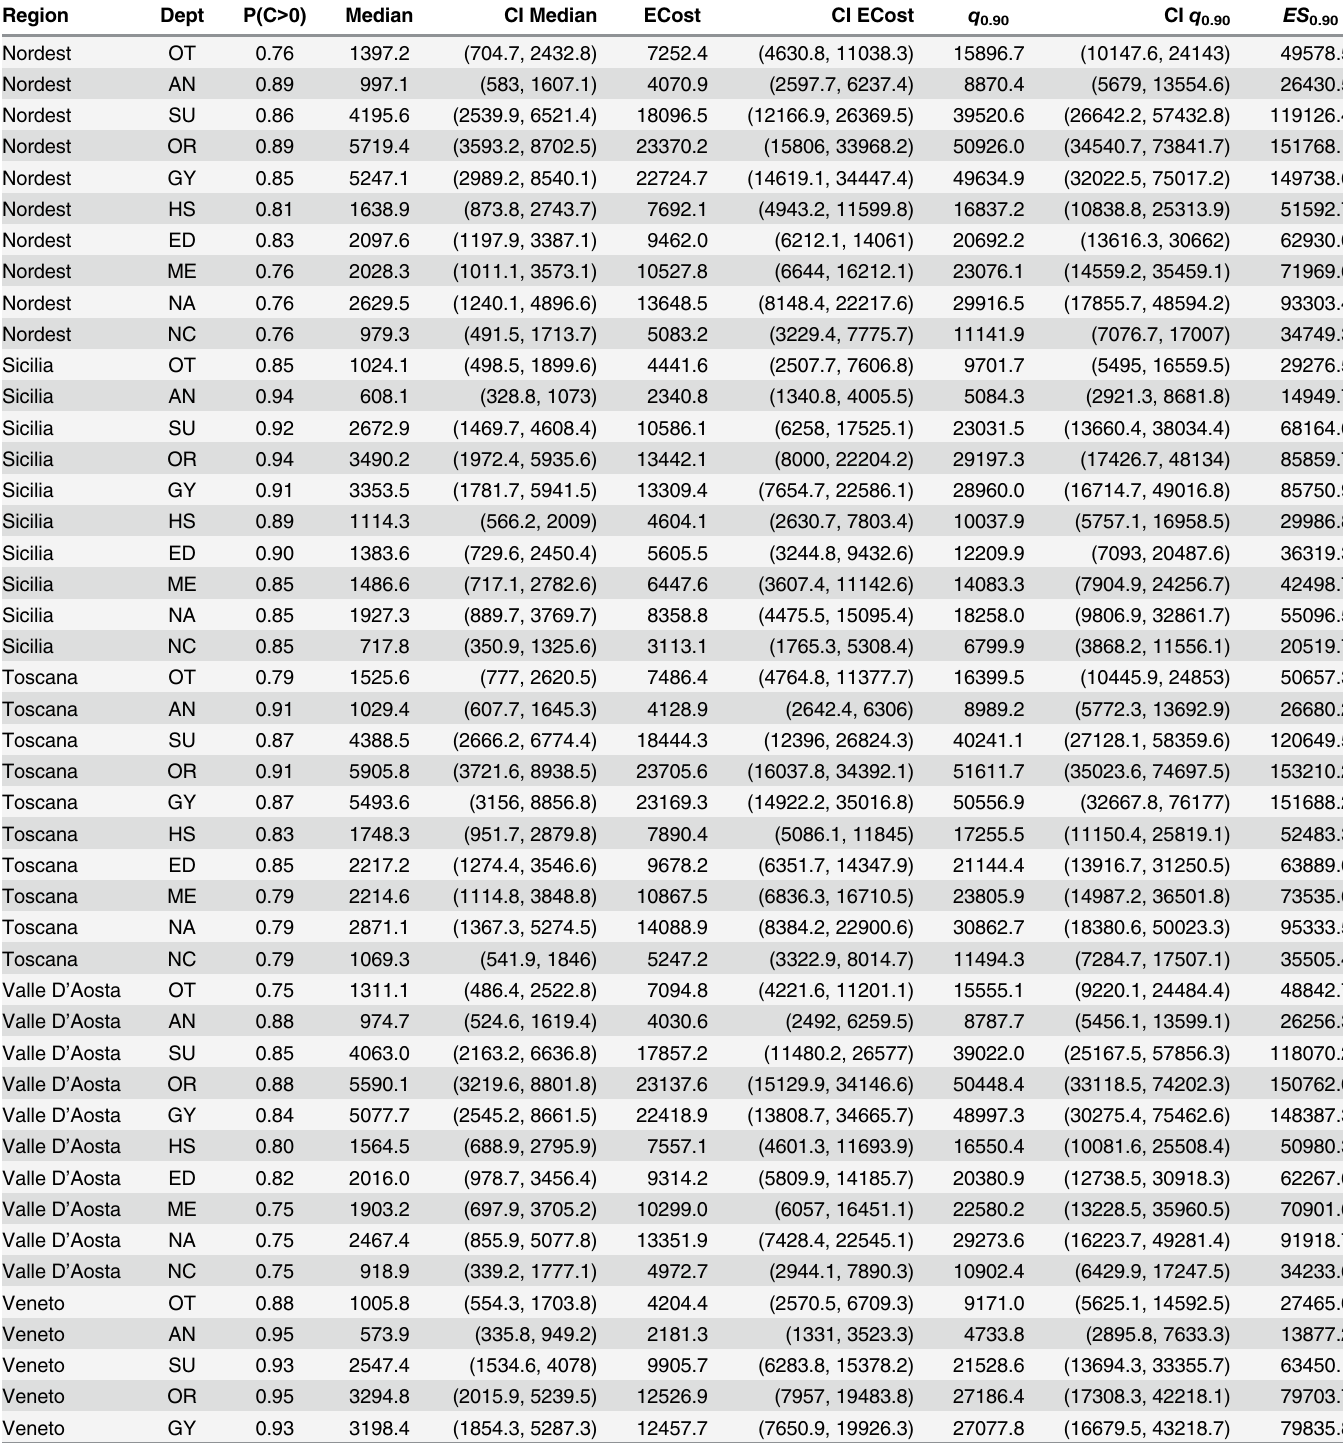
Table 17. Forecast probability of non-zero amounts, median amounts (with 95% confidence interval), expected amounts (with 95% confidence interval), 90th quantiles (with 95% confidence interval), and conditional 10%-tail expected amount (shortfall), by region x department as identified by the models. Forecasts refer to 30 June 2013.